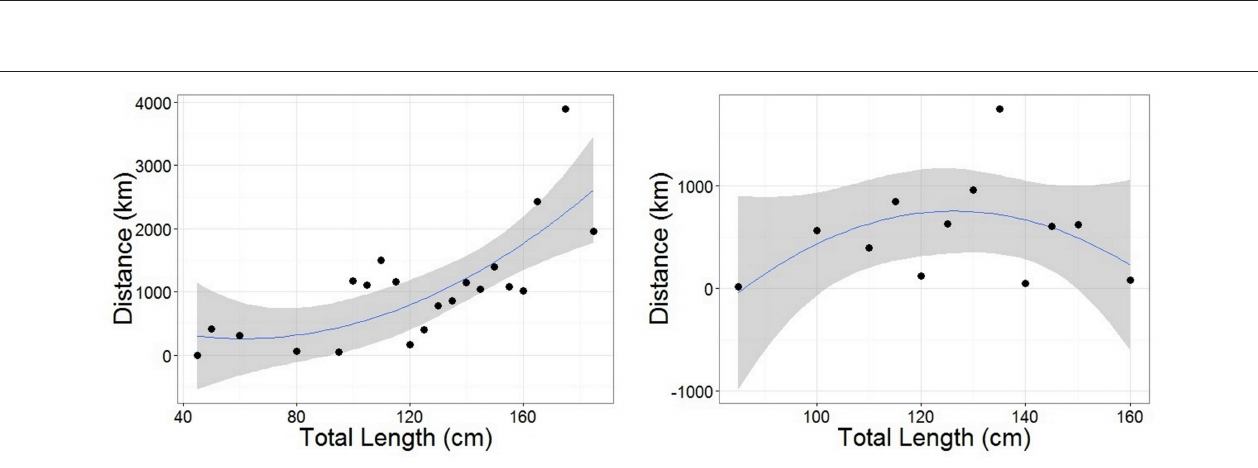
FIGURE 5 | Polynomial linear models of distance between tagging and recapture positions as a function of Total Length for females (Left) and males (Right) . Length data were grouped into 5cm classes. Distance was representative of the straight-line distance traveled by an individual from each length class (avoiding land for recaptures in the Mediterranean). Female model statistics: adjusted R 2 = 0.521, DF = 18, p < 0.05. Male model statistics: adjusted R 2 = 0.0783, DF = 9, p = 0.2809. Gray ribbon represents standard error.